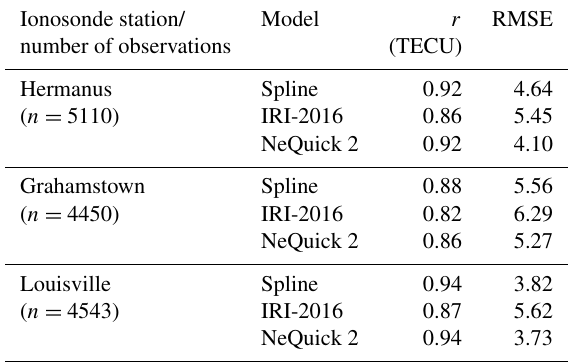
Table 3. Correlation coefficients, r and RMSE associated with esti- mation of TEC observed by ionosonde stations using